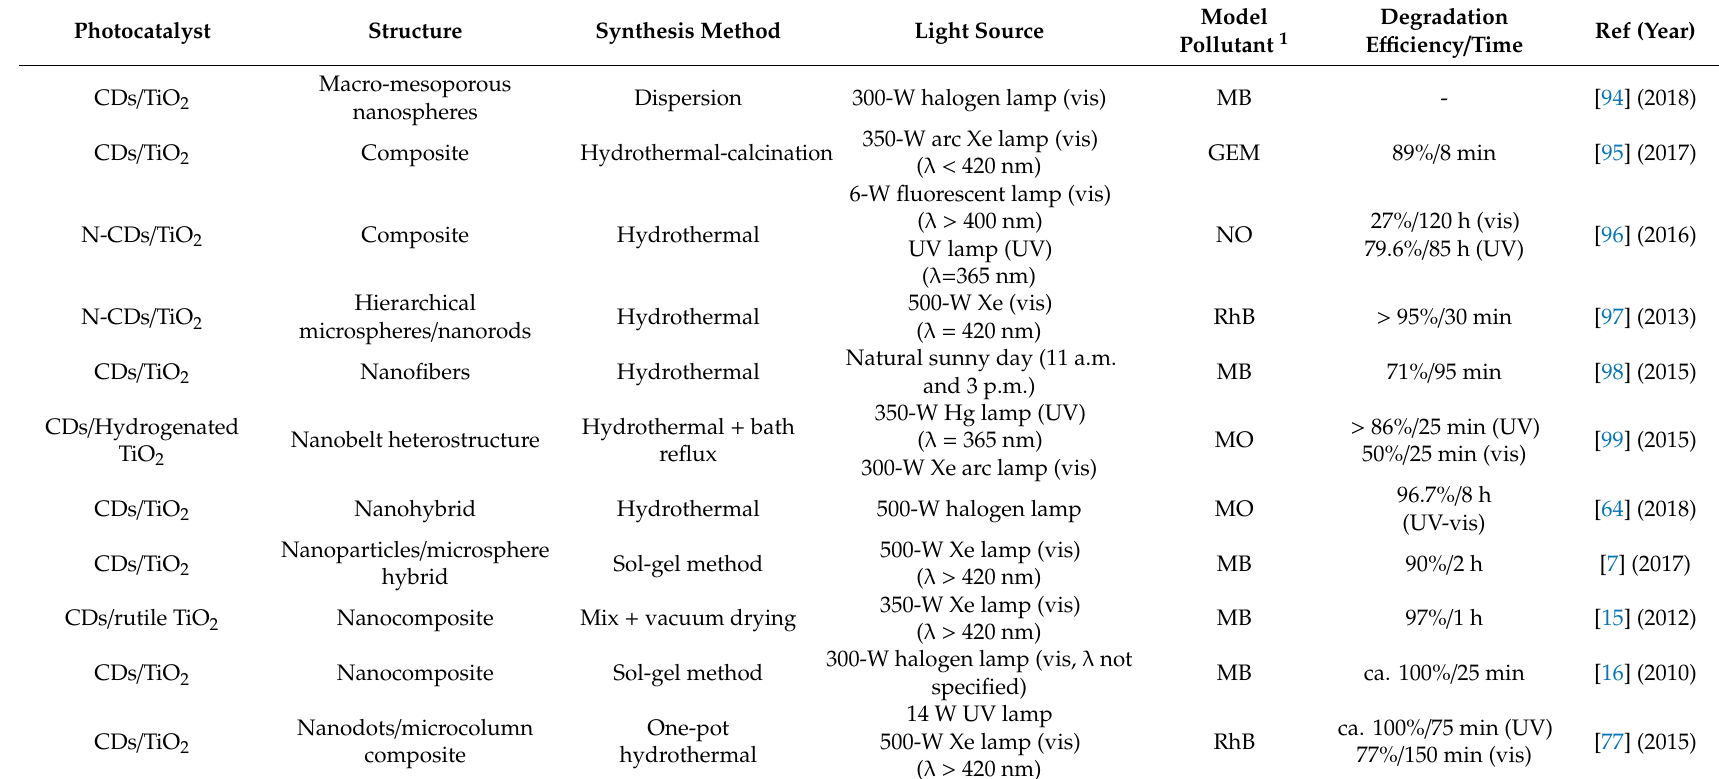
Table 6. Photocatalytic degradation activity of CDs /